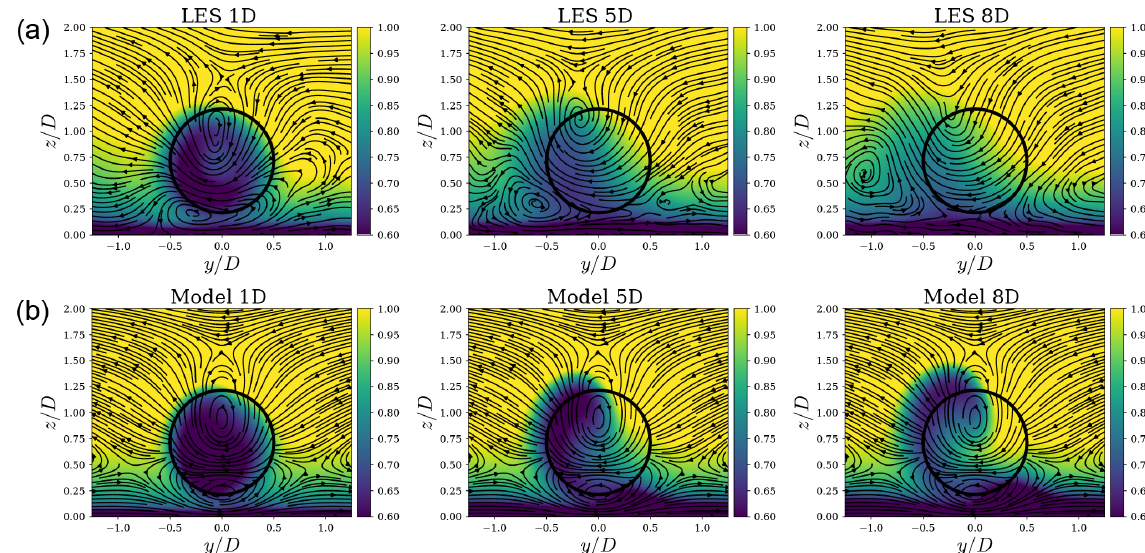
Figure 7. Comparison of streamwise velocity contours for the proposed model (b) with LESs of a wind turbine inside the atmospheric boundary layer (a) . The streamlines show the spanwise velocity